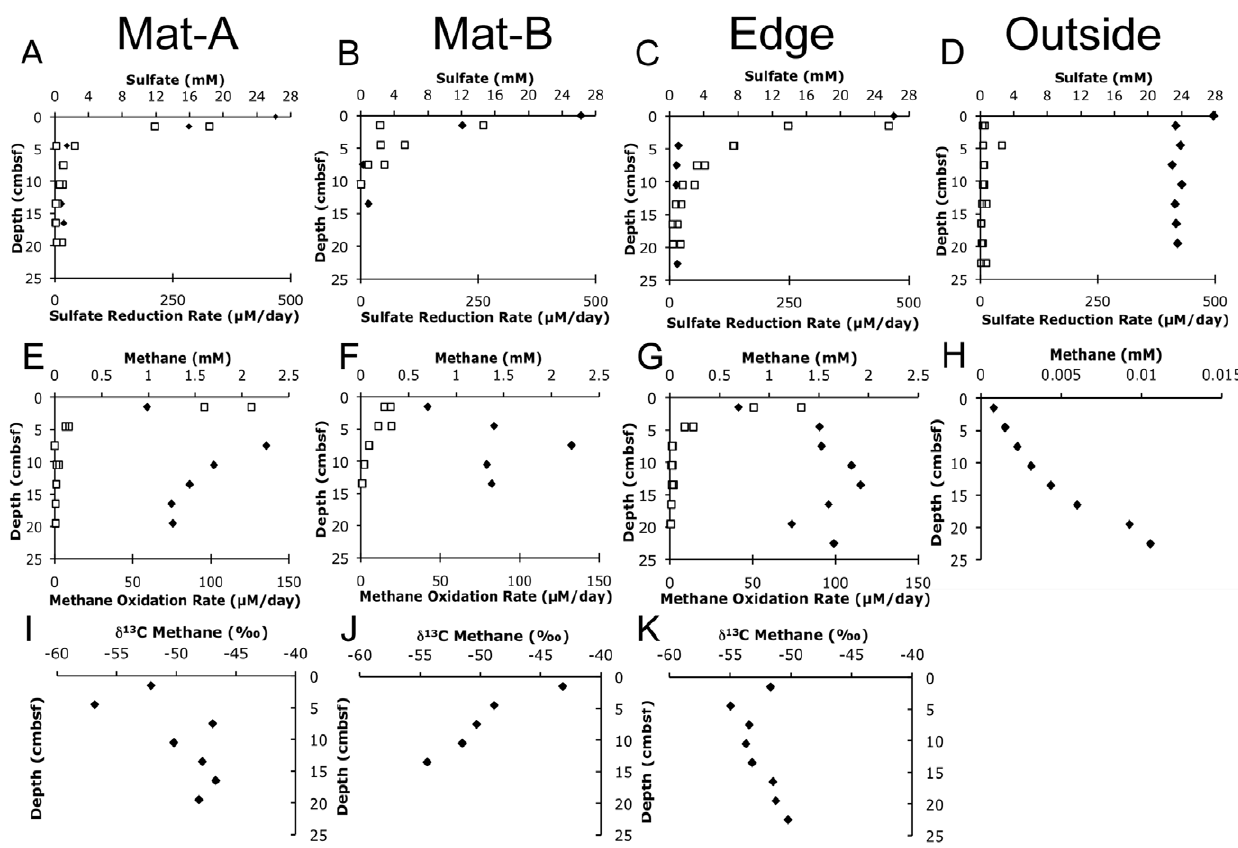
Figure 2. Geochemical measurements. Porewater measurements of A–D) sulfate concentrations (filled diamonds) and duplicate sulfate reduction rates (open squares), E–G) methane concentrations (filled diamonds) and duplicate methane oxidation rates (open squares), H) methane concentrations outside the mat with a smaller scale than the two other cores, and I–K) d 13 C values for methane. Cores are from within the mat (A, B, E, F, I, and J), at its edge (C, G, and K), and outside the mat (D and H). Methane concentrations above , 1.2 mM are lower limit estimations, since methane outgases to this value at normal atmospheric pressure. Only Mat-B, Edge, and Outside cores were used for microbiological analysis.